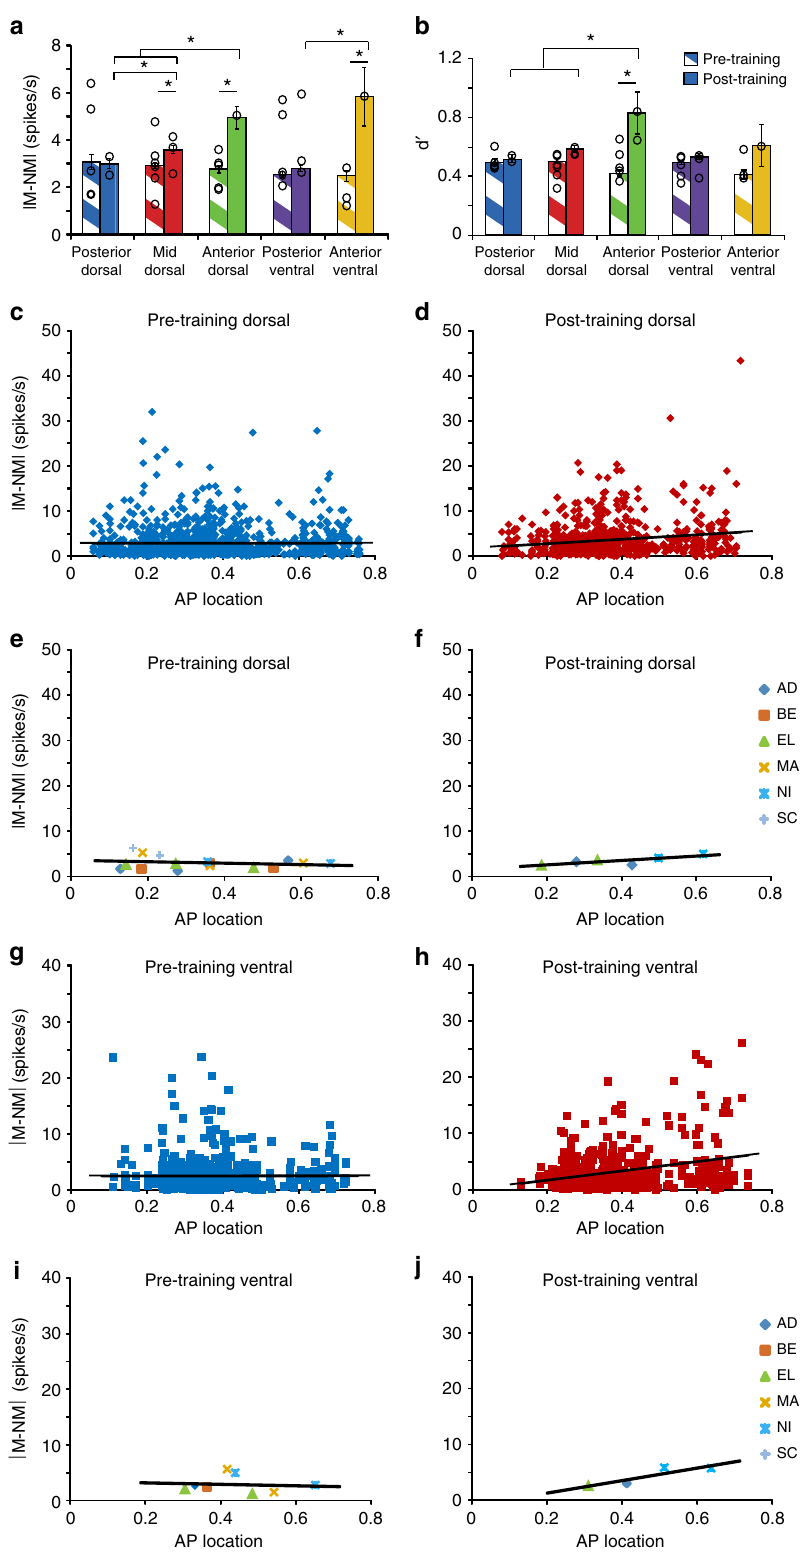
53%, − 10 and − 13% for the mid-dorsal, anterior-dorsal, posterior- ventral, and anterior-ventral areas, respectively. In contrast, when we compared passive presentation of stimuli recorded before training and after training, signi fi cant increases were present for the mid- dorsal, posterior-ventral, and anterior-ventral areas (1-tailed t -test,